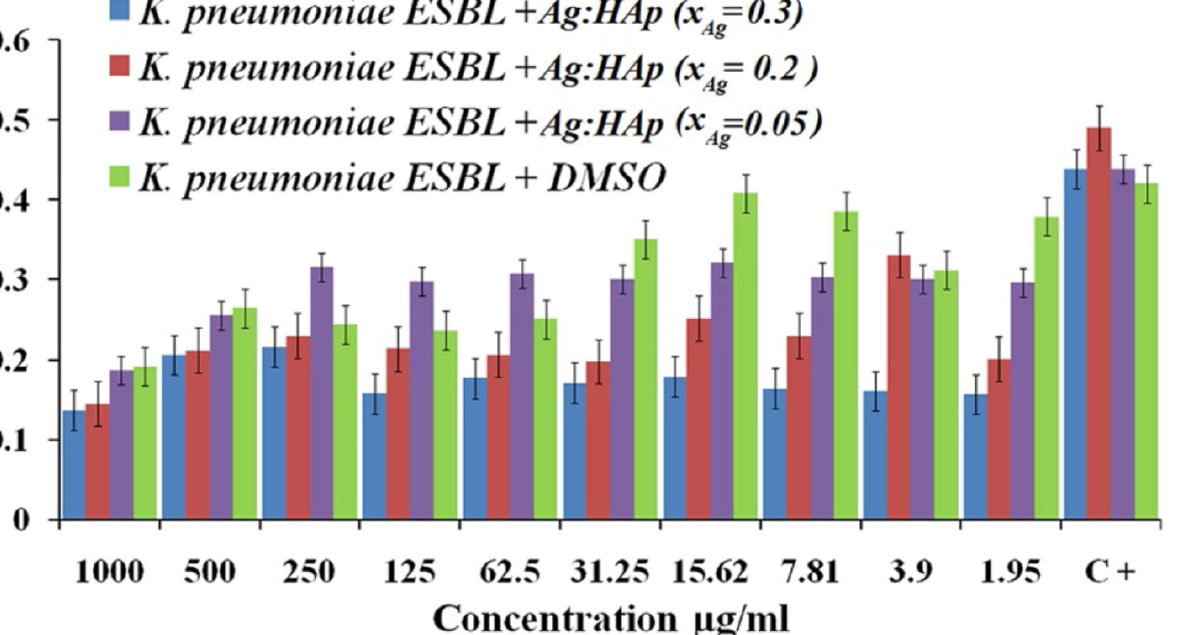
Figure 5. Zones of inhibition of multidrug-resistant bacteria by conventional antibiotics and AgNPs. ( A ) Bacillus ; ( B ) Micrococcus luteus ; ( C ) Staphylococcus aureus ; ( D ) Enterococcus faecalis ; ( E ) E. coli ; ( F ) Pseudomonas aeruginosa ; ( G ) Acinetobacter baumannii ; ( H ) K. pneumoniae . Adapted from [112] , Dove Medical Press Ltd., Macclesfield, United Kingdom, 2013. Au NPs are an antibacterial nanoparticle that has been used as a treatment agent for K. pneumoniae in recent decades. Ayaz Ahmed and colleagues tested the antibiofilm effi- ciency of gold nanoparticles linked with chlorhexidine (Au CHX) towards K. pneumoniae . MTT assay was used to determine biofilm inhibition and eradication, and florescence and AFM microscopy were used to confirm these findings. A surface plasmon resonance (SPR)